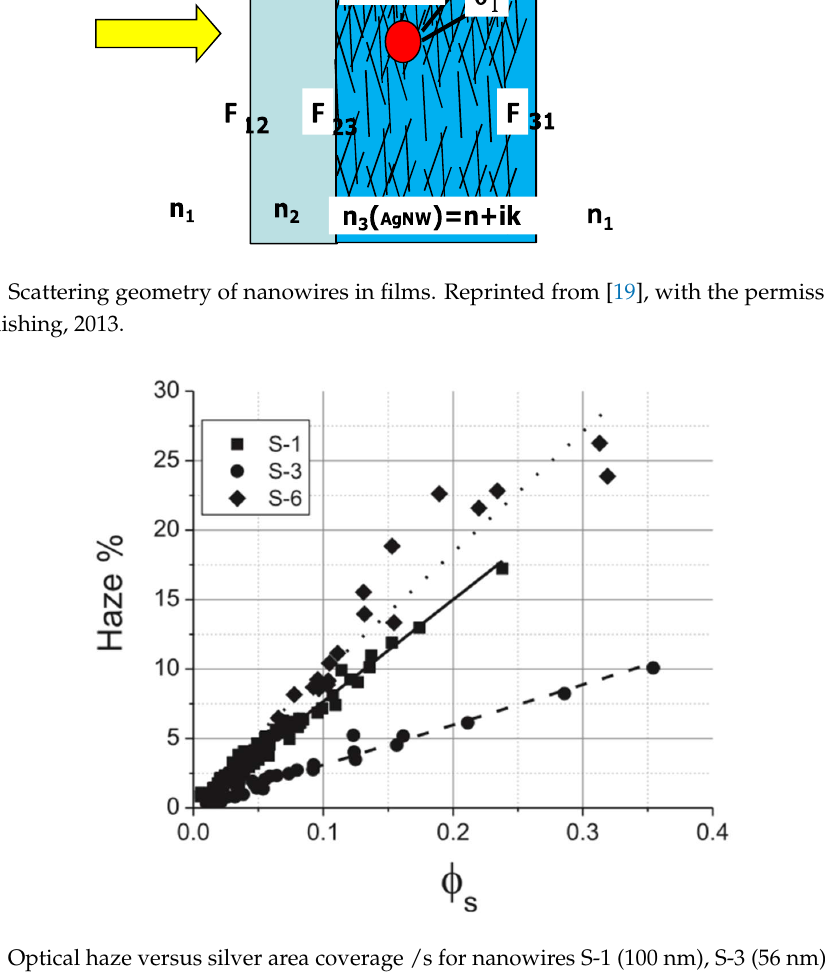
Figure 3. Optical haze versus silver area coverage /s for nanowires S-1 (100 nm), S-3 (56 nm), and S-6 (153 nm). Calculated curves are shown as (_____, S-1), (- - - - , S-3) and (........., S-6). Reprinted from [19], with permission from AIP Publishing, 2013.